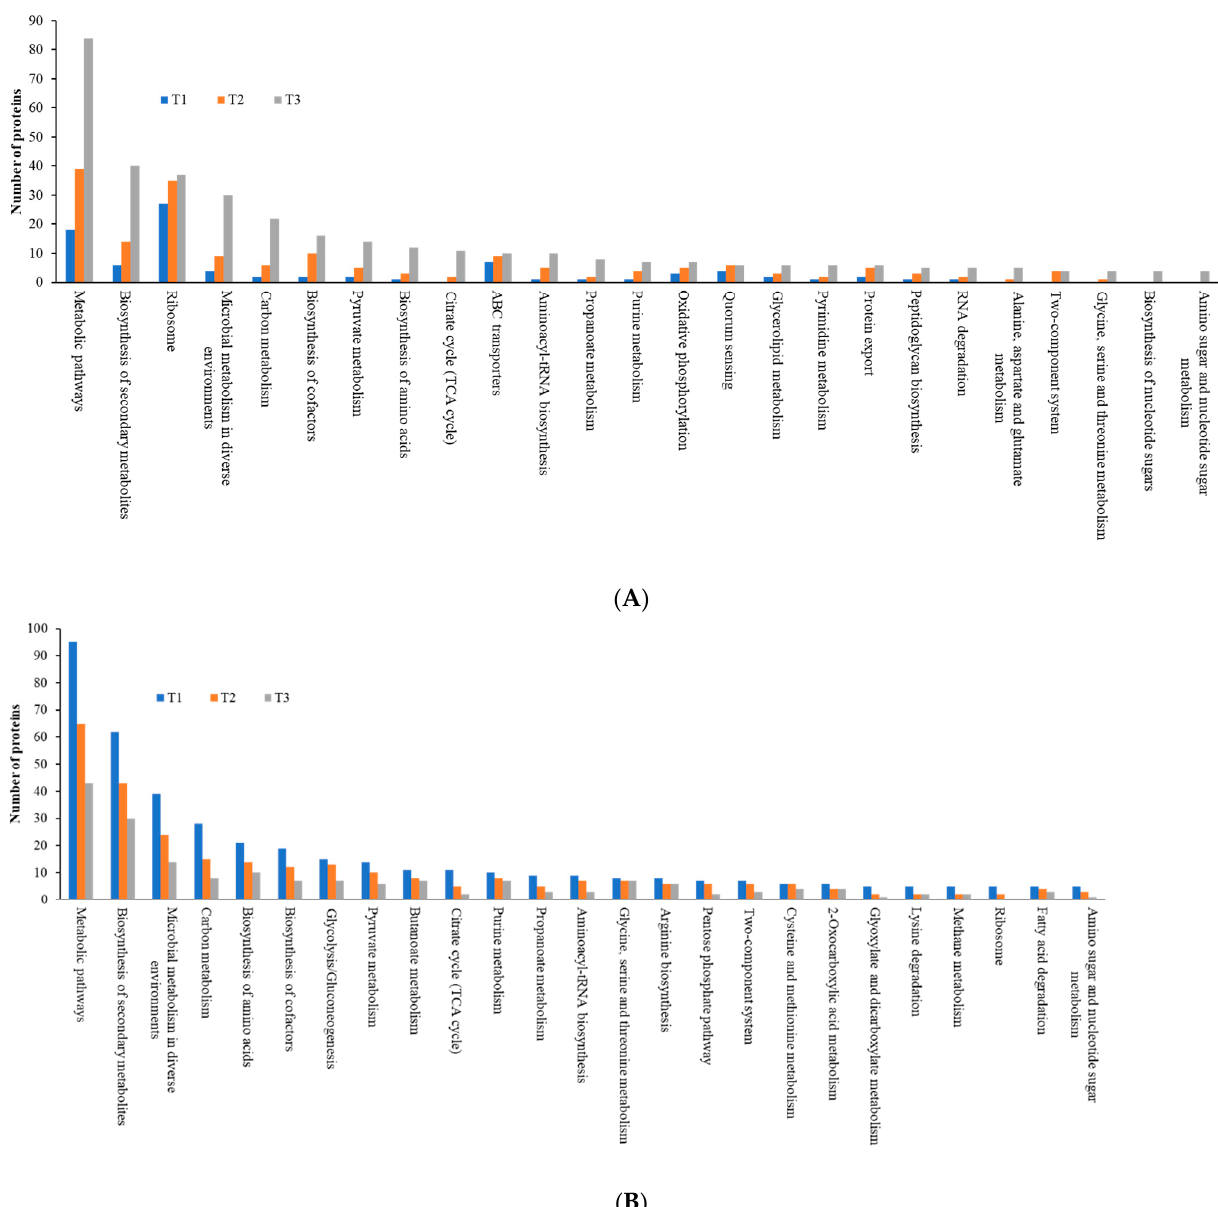
Figure 11. Top 25 KEGG pathways in differentially expressed proteins identified from S. epidermidis strain RP62A biofilms grown with sublethal MIC of TC. ( A ): upregulated proteins, ( B ): downregulated proteins, T1: 1/8 MIC, T2: 1/4 MIC, T3: 1/2 MIC.